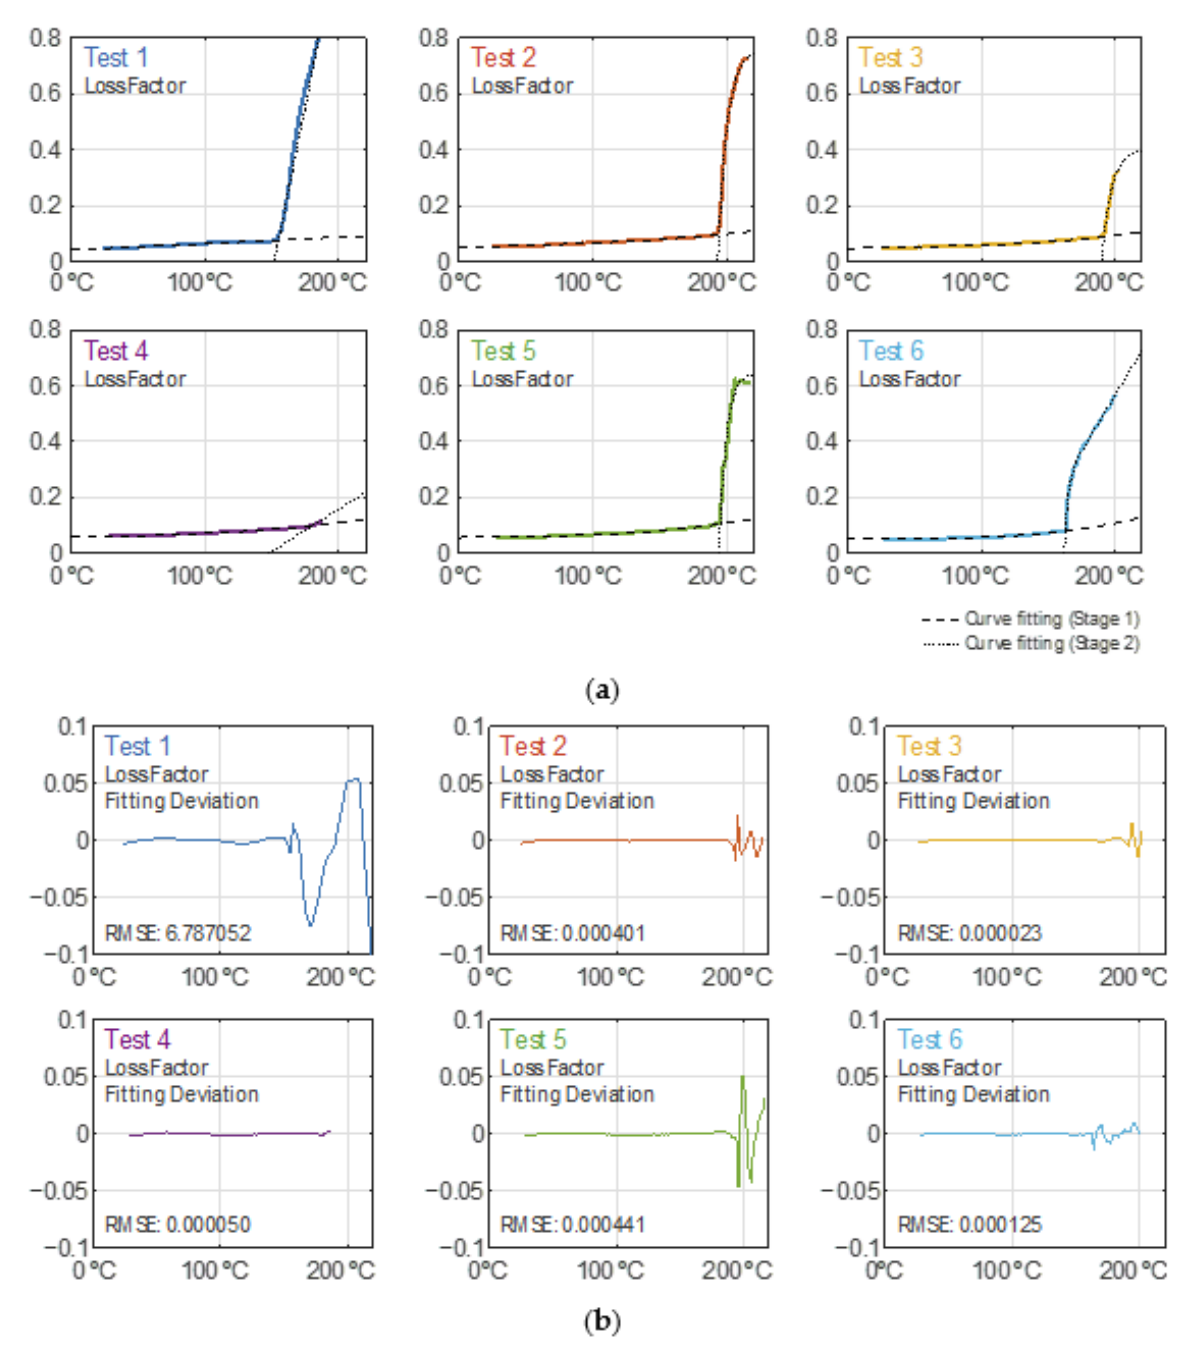
Figure 8. ( a ) Loss factor behavior during the heating and curve fitting modelling for each test. ( b ) Loss factor curve modelling absolute residuals (linear scale) for each test. From the obtained results, one can conclude that both the dielectric constant and loss factor monotonically increase as the sample temperature increases. It is when the temperature overcomes a certain temperature threshold that the dielectric parameters grow significantly. The temperature threshold for each piece (stage) defined by Equation (5) differs for each test due to their particular curve kinks (modeled by the parameter b 2 ) as a result of their own microwave irradiation profiles, as noticed in Figures 7a and 8a. The case for the Test 4 curves does not show as sharp a kink as in the other